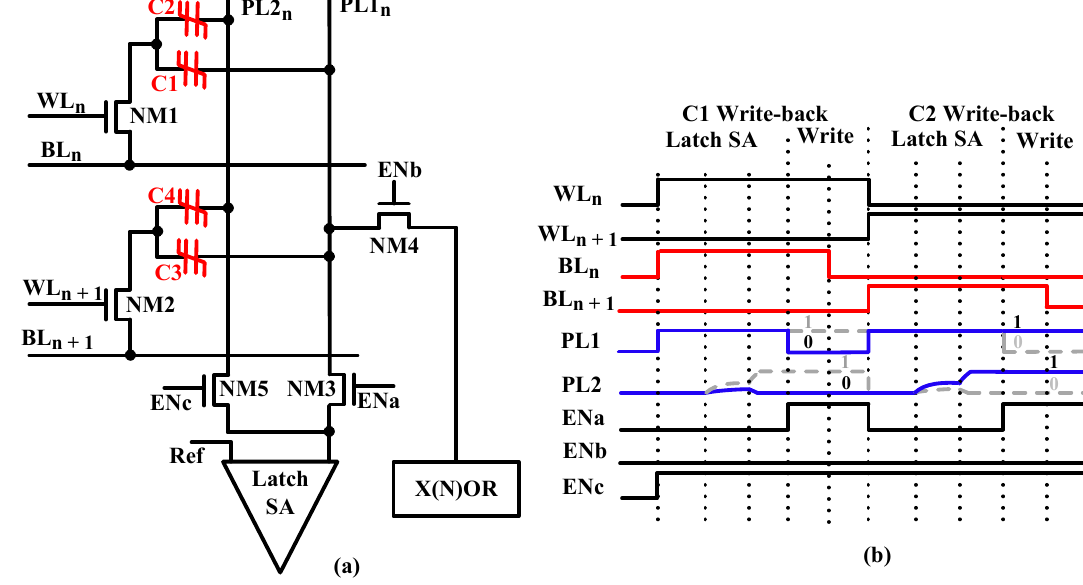
Figure 12. ( a ) The two-step write-back circuit of the 1T2C-type FeCAP. ( b ) Timing of the two-step write-back